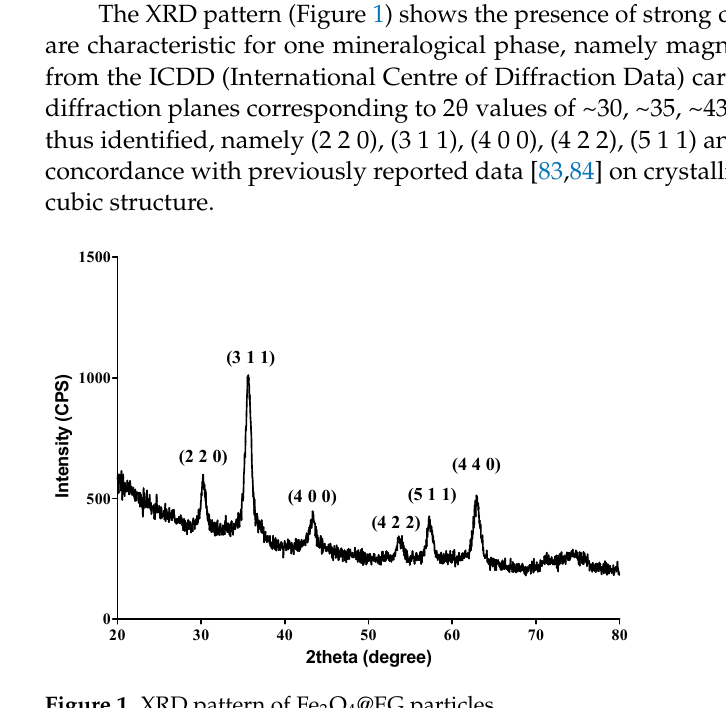
Figure 1. XRD pattern of Fe 3 O 4 @EG particles.